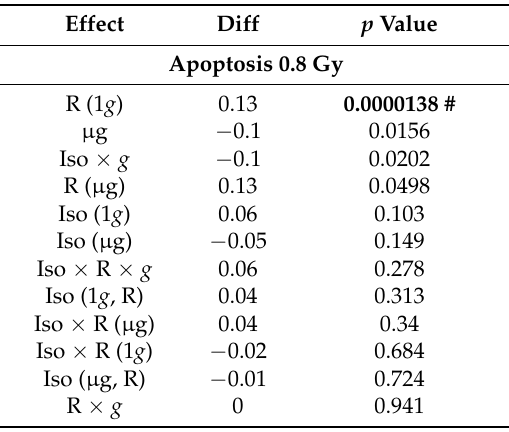
Figure 2. Apoptosis rate (calculated as indicated in Table 1) and residual DNA strand breaks after 24 h incubation in RWVs in µg or 1 g . Apoptosis rate is represented by the mean transformed values ( A ) and ( B ) and DNA strand breaks are means expressed in Gy dose equivalent ( C ). Nontreated cells (C), isoproterenol (Iso) and radiation (R) treated cells. Error bars represent +1 SEM. Statistical analysis are summarized in Table 1. Table 1. Estimated change (diff) in mean transformed apoptosis rate and DNA strand breaks. Effects listed below are described in Table 7.